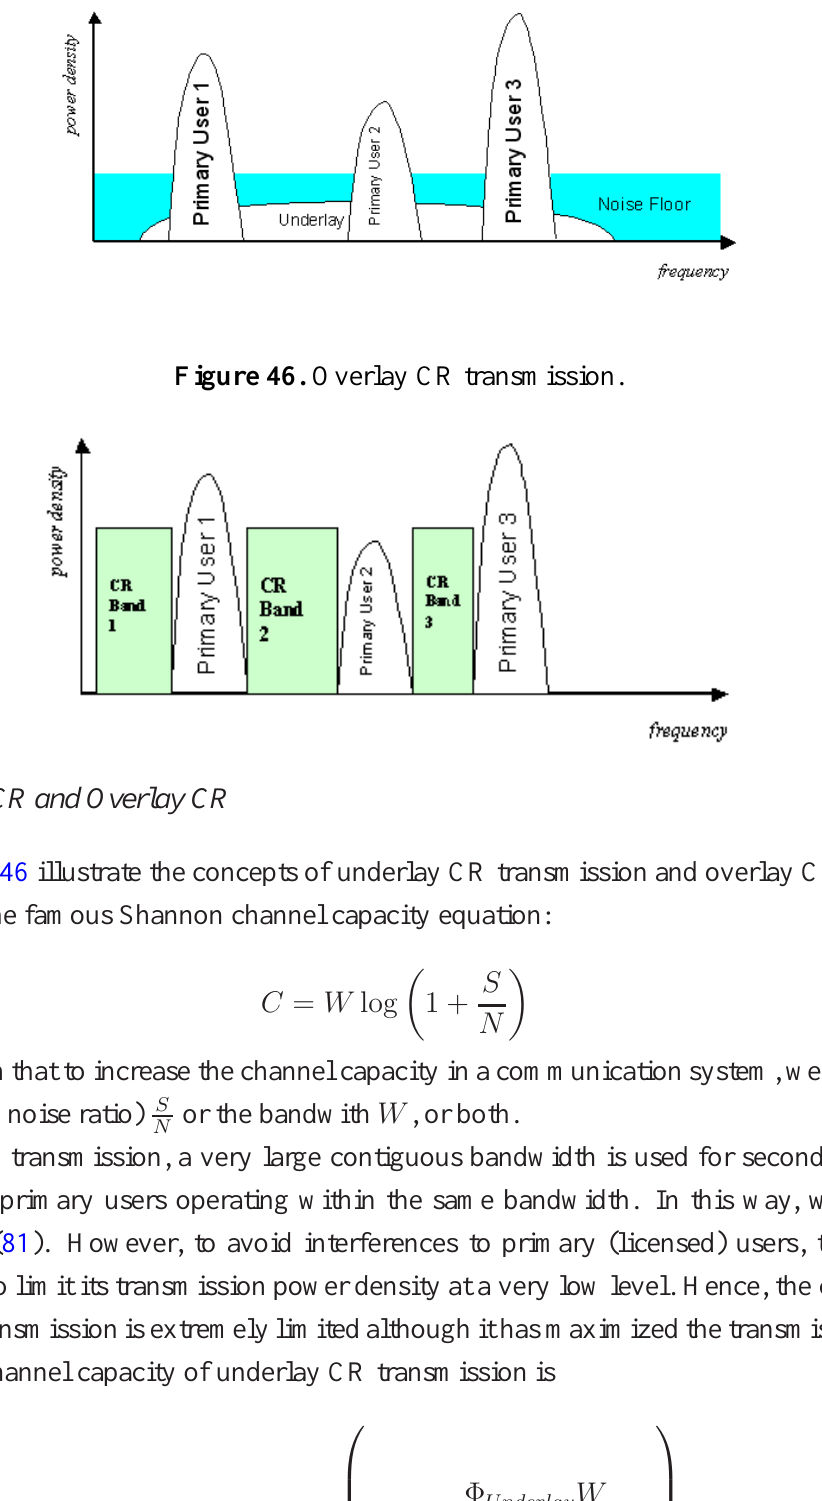
Figure 45. Underlay CR transmission.